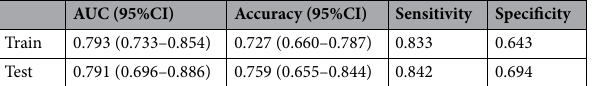
Table 3. Diagnostic efficacy of the radiomics model in the training and test